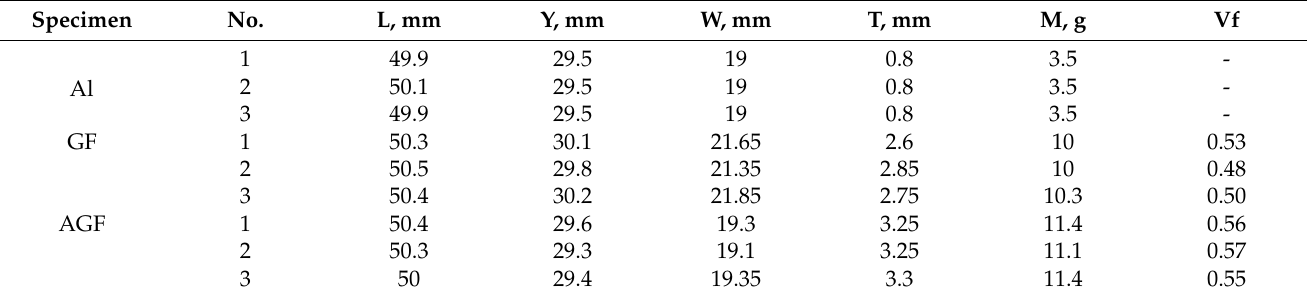
Table 1. Axial compression specimen dimensions and volume